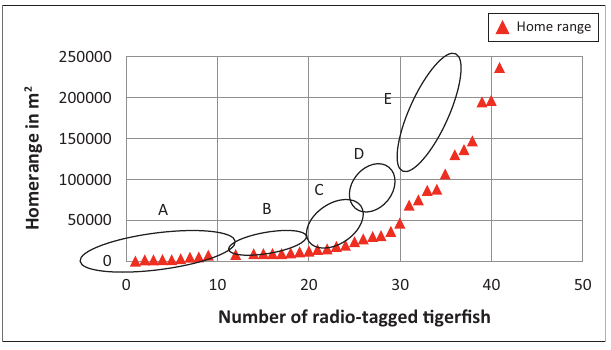
FIGURE 7: Clustering of home range sizes of radio-tagged fish. A, 0 m 2 –10 000 m 2 ; B, 10 001 m 2 –20 000 m 2 ; C, 20 001 m 2 –50 000 m 2 ; D, 50 001 m 2 –100 000 m 2 ; E, > 100 000 m 2